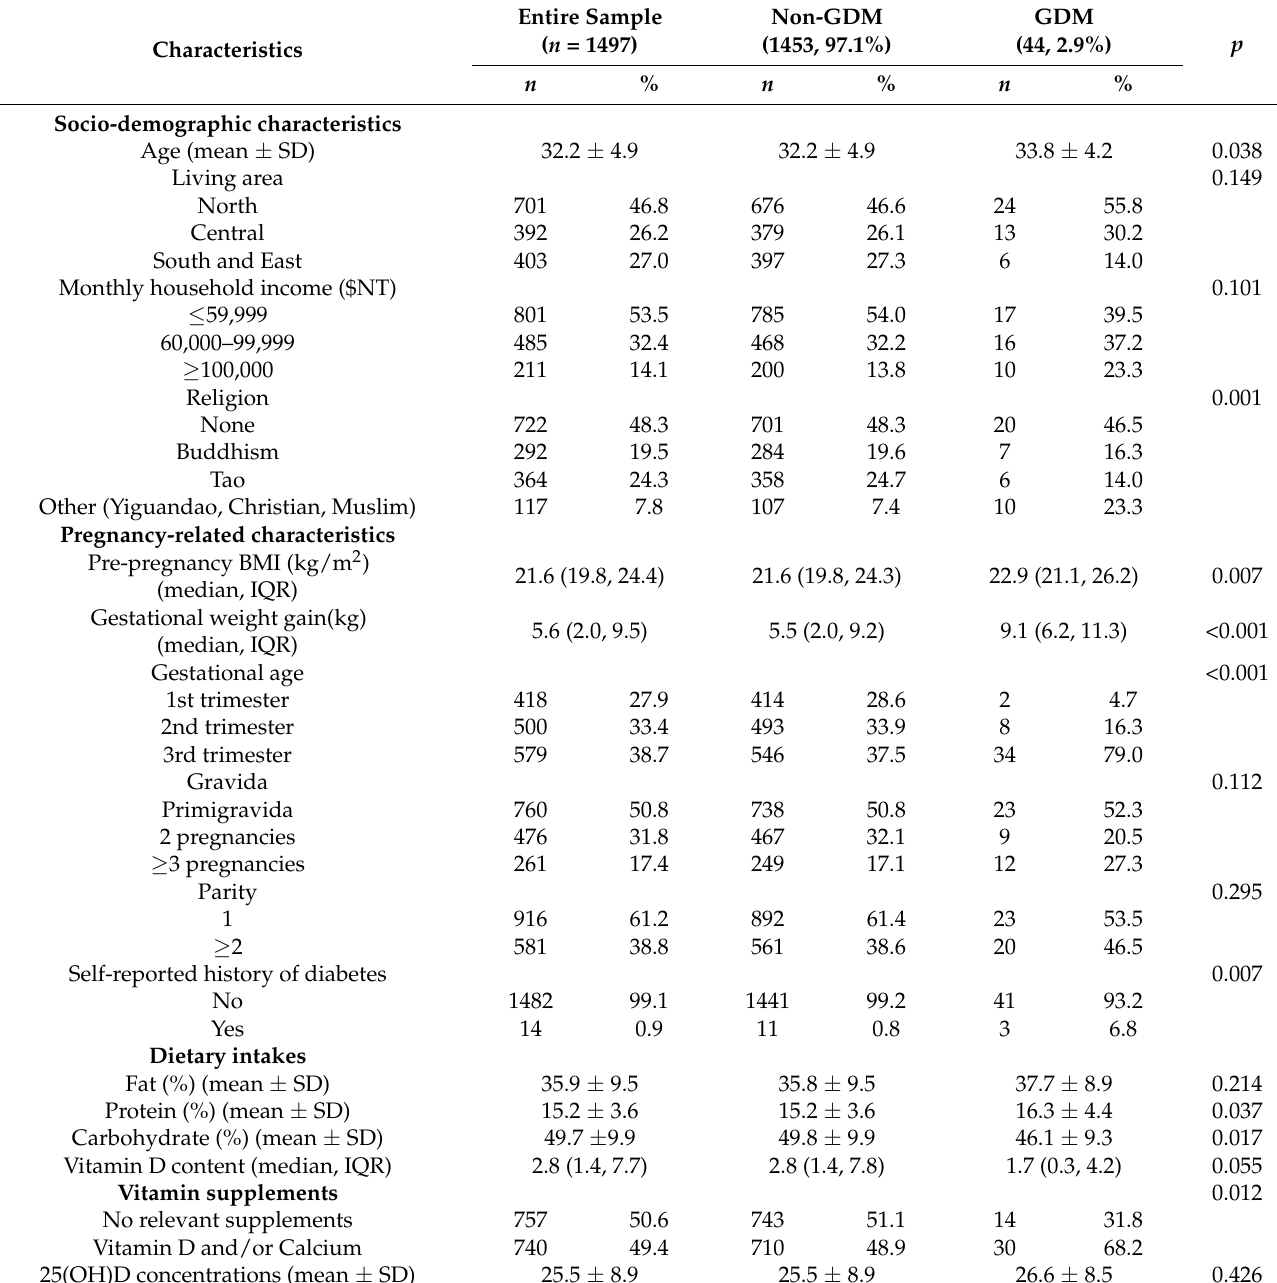
Table 1. Participants’ characteristics according to gestational diabetes mellitus